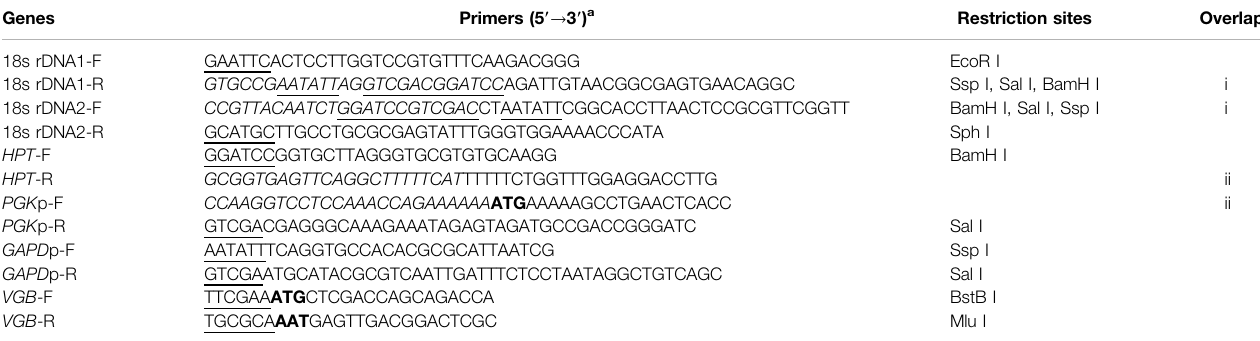
TABLE 1 | Primers used for plasmid construction and veri fi cation. Genes